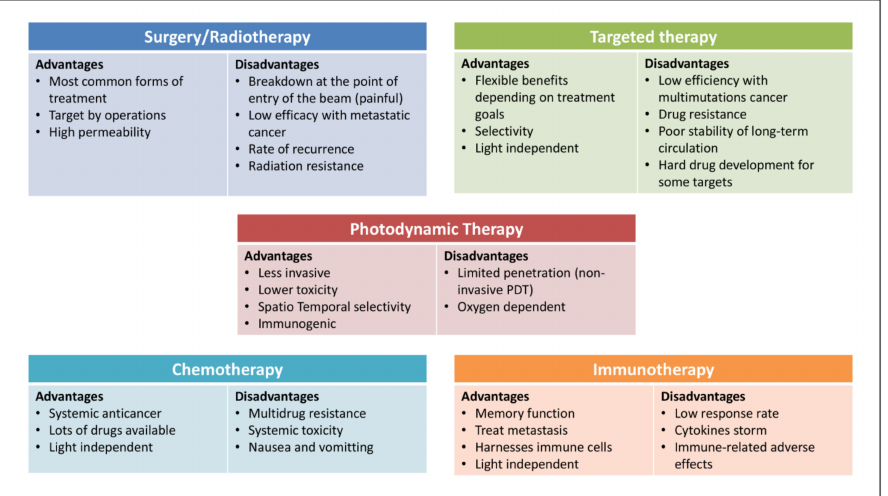
Figure 3. Summary of the advantages and disadvantages of major cancer therapies. PDT-based com- bination therapies for the treatment of cancer integrate the advantages and bypass the disadvantages of monotherapies, including surgery, radiotherapy, targeted therapy, immunotherapy, and other combined